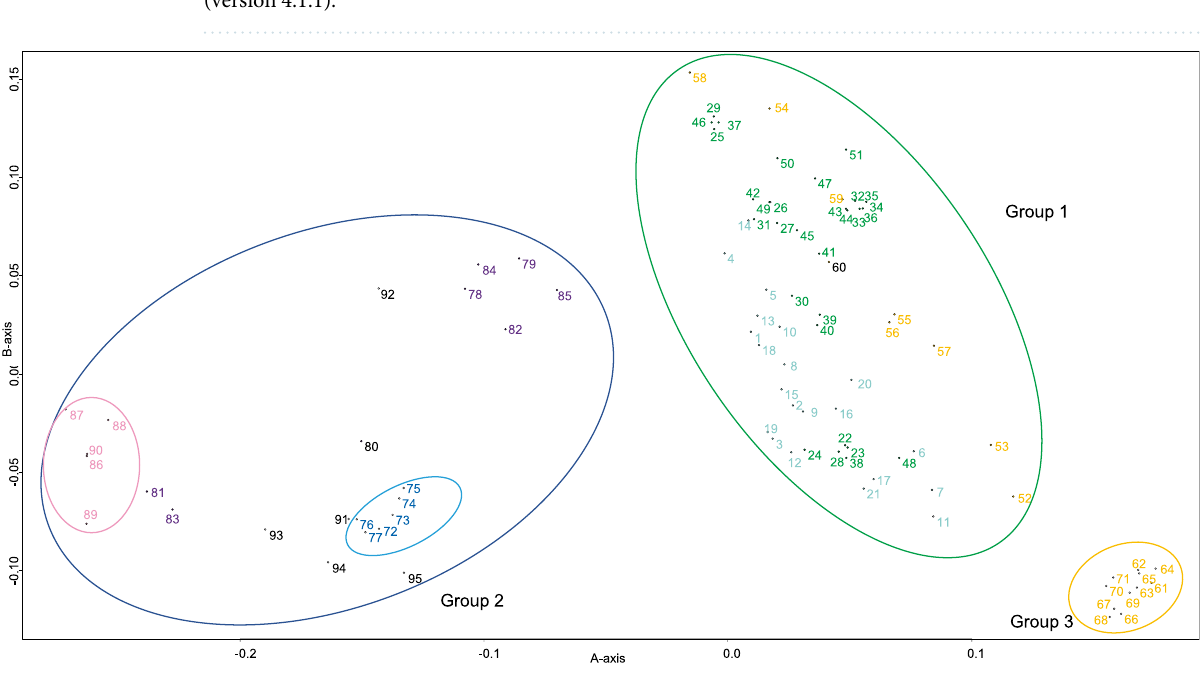
Figure 3. Multidimensional scaling of Eriobotrya japonica accessions using 2-dimensional data based on 1822 SNP markers. The color scheme is the same as in Fig. 1. Figure was generated using R software (version